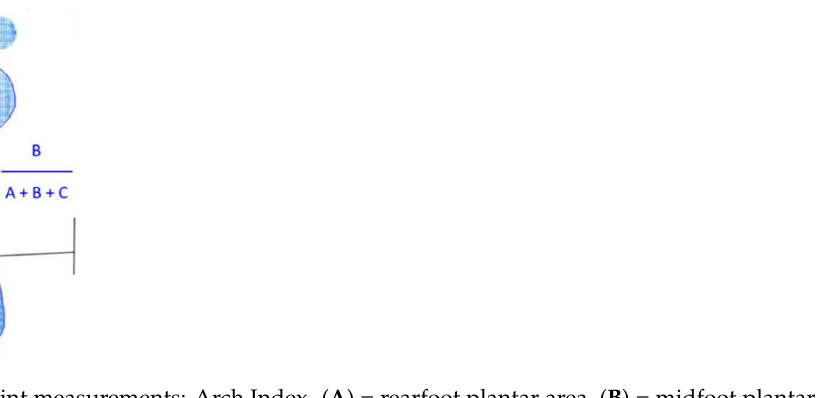
Figure 3. Footprint measurements: Arch Index. ( A ) = rearfoot plantar area, ( B ) = midfoot plantar area, ( C ) = forefoot plantar area excluding the toes.